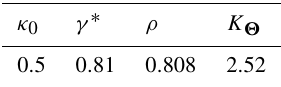
Figure 9. (a) PRBM of the curved beam, and (b) initially curved wiper pressing arm. Table 1. γ ∗ , ρ , and K (cid:50) as a function of κ 0 .